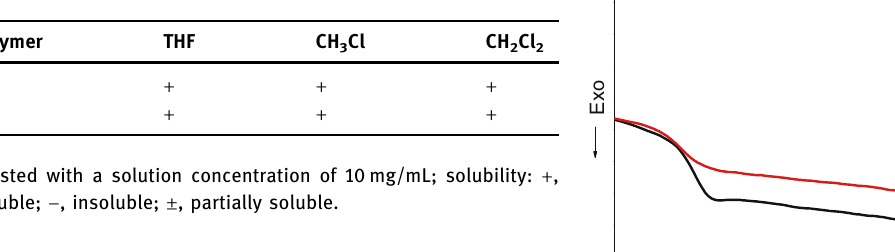
Table 2: Polymer solubility at room temperature*